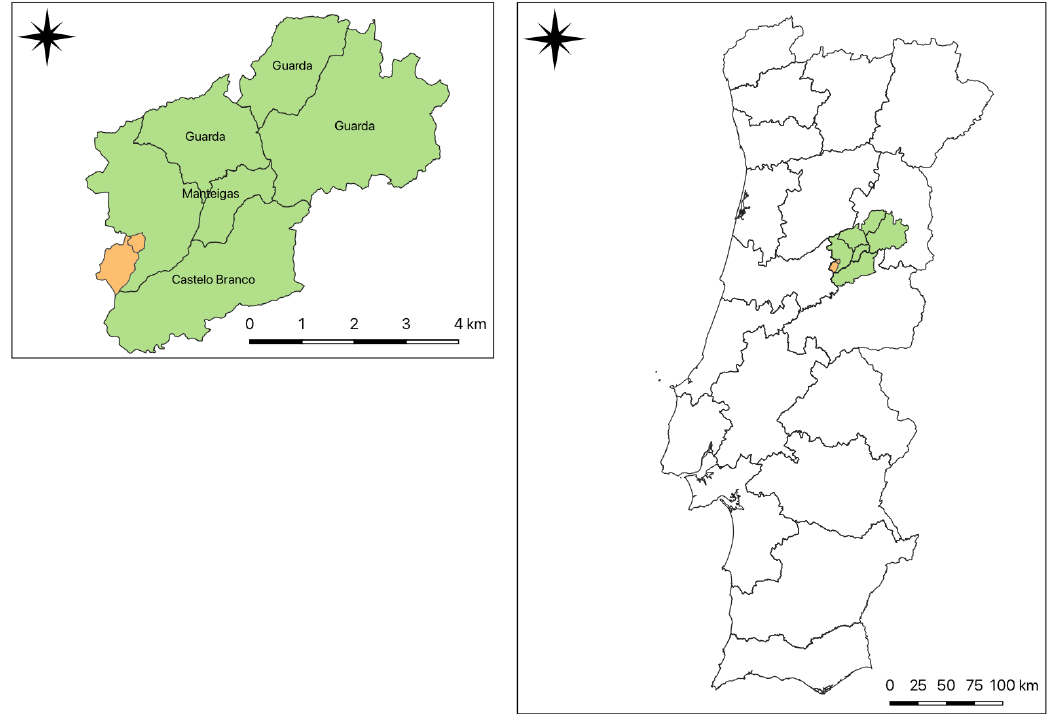
Figure 2. Location of the study area, in the União de Freguesias de Cabeça e Vide, in the municipality of Seia, in the district of Guarda.